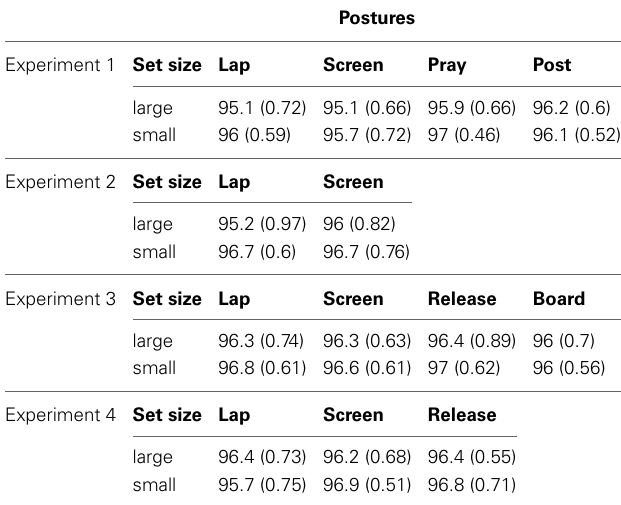
Table 2 | Mean percent correct and corresponding standard errors in parentheses for the conditions of Experiments